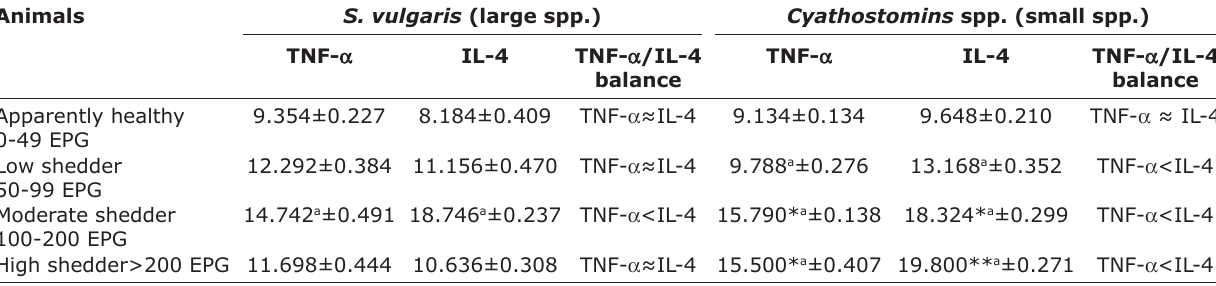
Table-5: Blood levels of TNF- α and IL-4 in apparently healthy and strongylus infected donkeys (ng/ml). Animals S. vulgaris (large